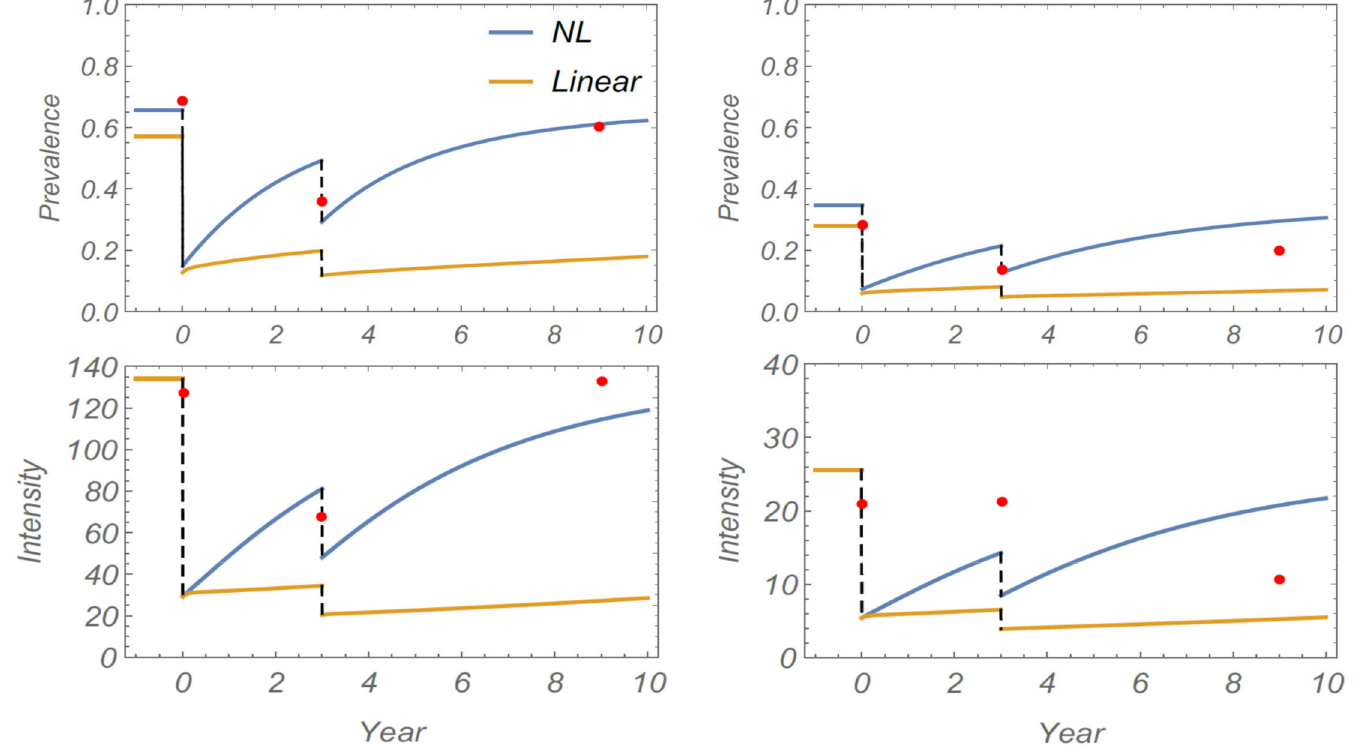
Fig 4. Simulation of 9-year control study for Milalani community using linear M1 (yellow) or non-linear M2 (NL, blue) study model simulations. Model comparison with observed field data (red dots) for S . haematobium infection prevalence (top graphs) and mean intensity in eggs per 10 mL urine (bottom graphs). The left graphs indicate results for children, the right graphs indicate results for adults. Model parameters of Table 3 were used for both systems.